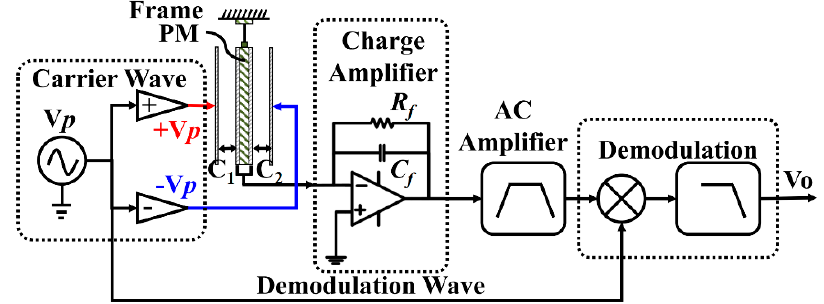
Figure 1. Diagram of a typical capacitive transducer, including carrier wave modulation, charge amplifier, alternating current (AC) amplifier, and demodulation. V p is the carrier wave and also the demodulation wave. C 1 and C 2 are the differential capacitances. In a charge amplifier, R f is the feedback resistance and C f is the feedback capacitance.